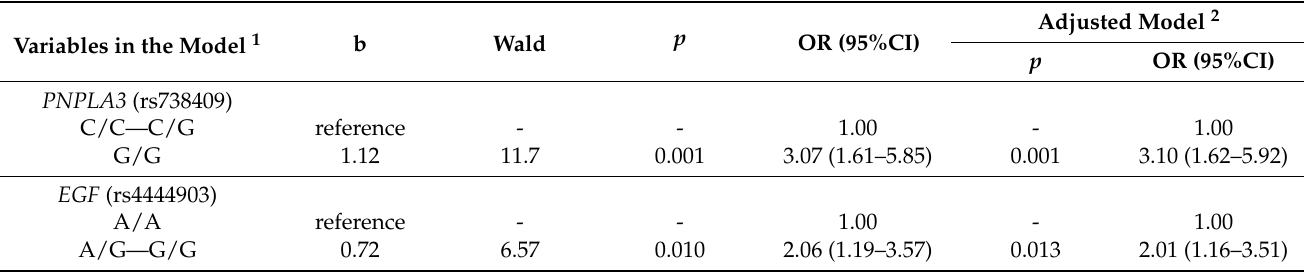
Table 5. Logistic regression analysis of predictors for hepatocellular carcinoma